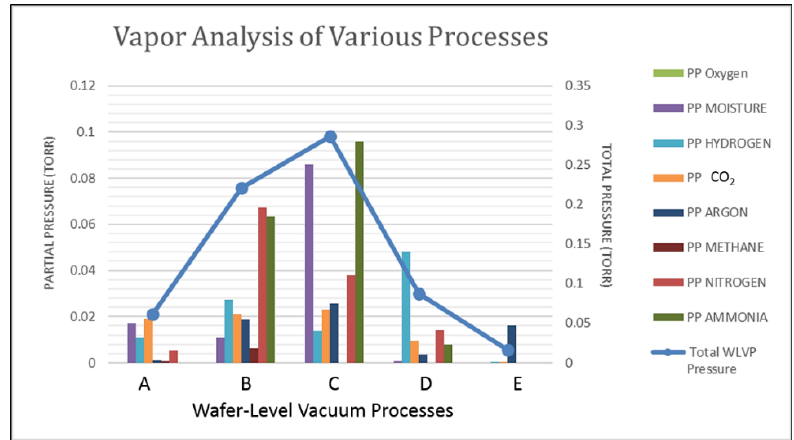
Figure 18. Spectra data from a high-resolution internal vapor analysis (HR-IVA) that was converted into partial and total package pressure values [103].